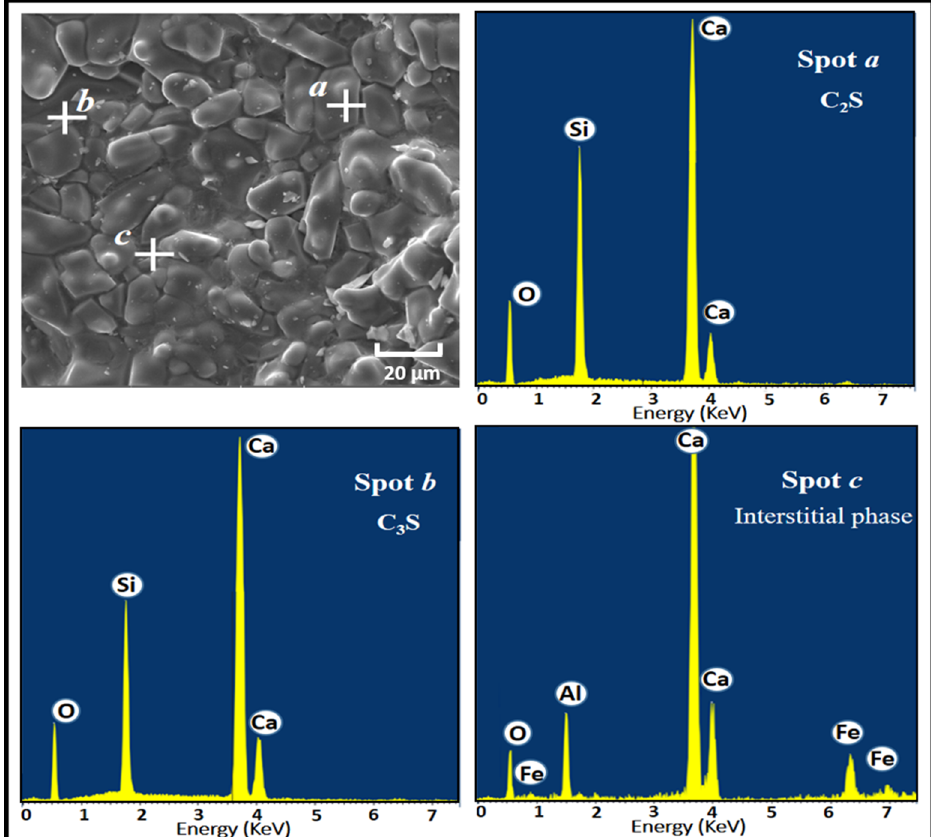
Figure 10. SEM micrograph and EDS spectra of the cement clinker CF3.